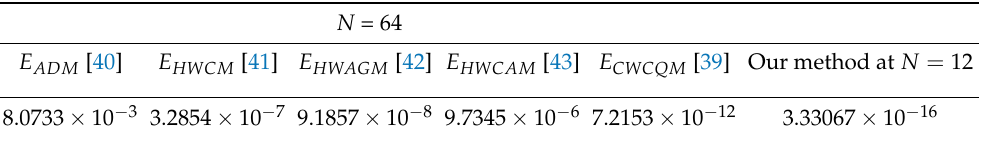
Table 1. Comparison of L ∞ error of Example